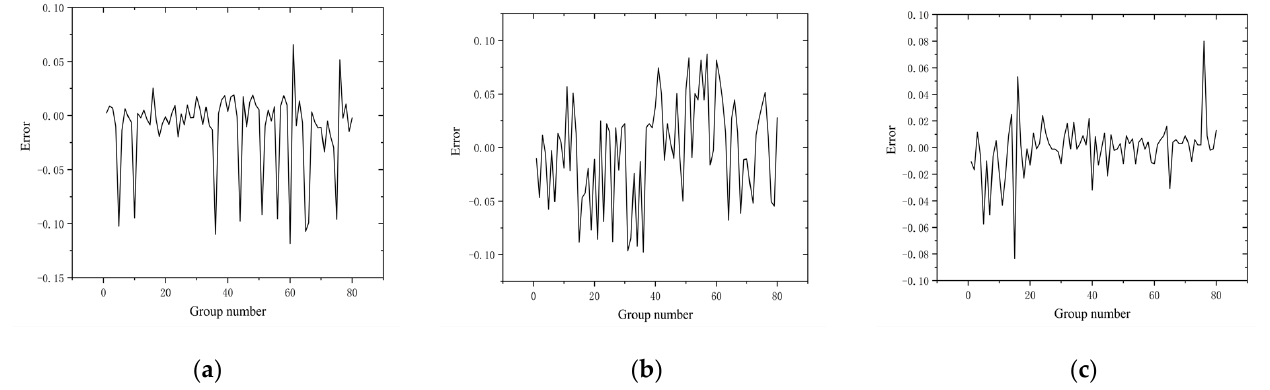
Figure 20. Time − error chart. ( a ) 20 mm/s. ( b ) 40 mm/s. ( c ) 60 mm/s.